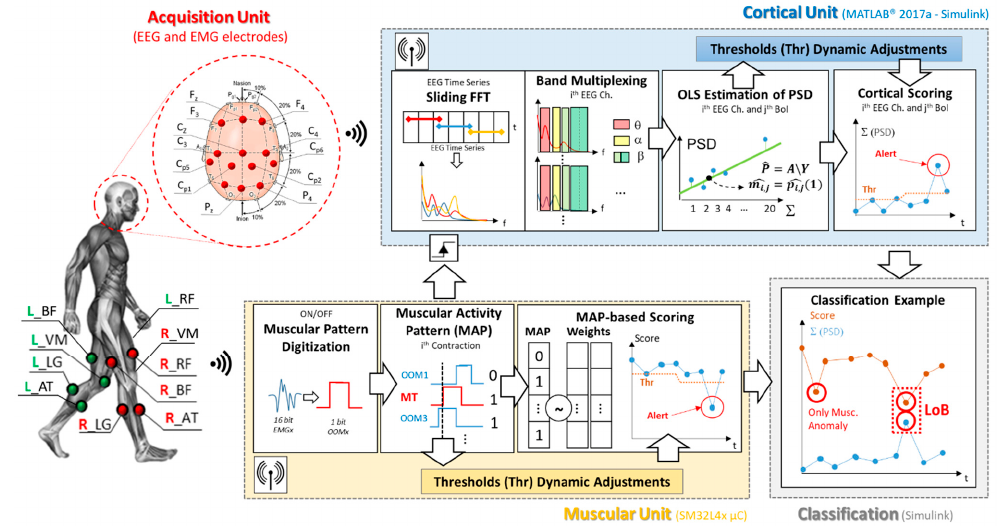
Figure 1. Proposed architecture block diagram. The figure shows the electroencephalography / electromyography (EEG / EMG) experimental setup, as well as the graphical representation of the working flow of each involved